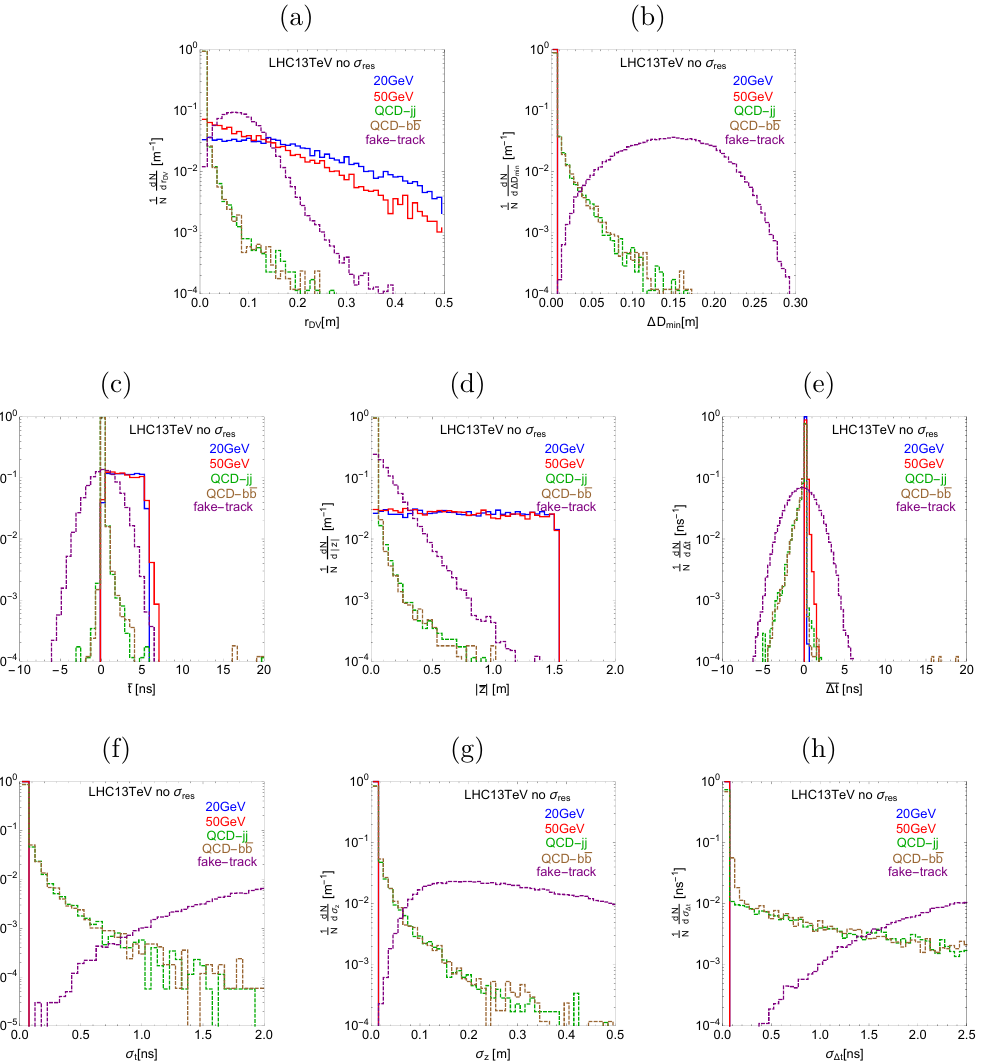
Figure 7 . The kinetic variable distributions for the QCD background, fake-track background and the signal without the angular resolution effect included. The variables and definitions are the same as figure